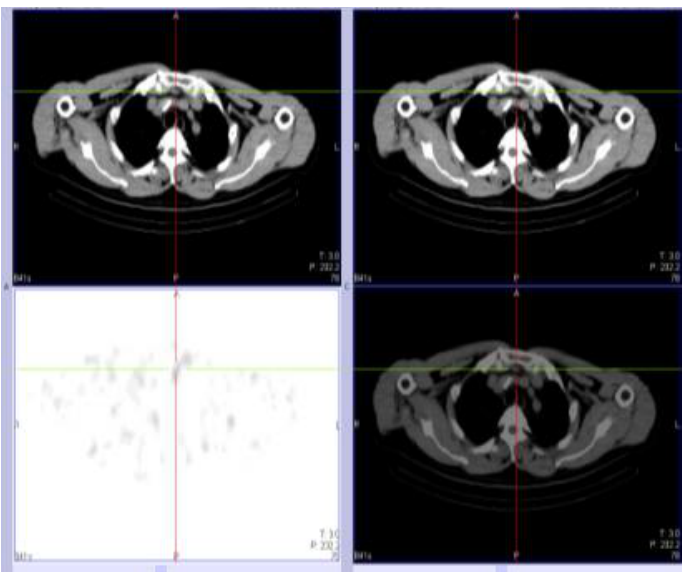
Fig. 5 99mTc-MIBI SPECT-CT image of substernal heterotopic parathyroid glands(cross) Example 3 Patient (See Fig. 6)